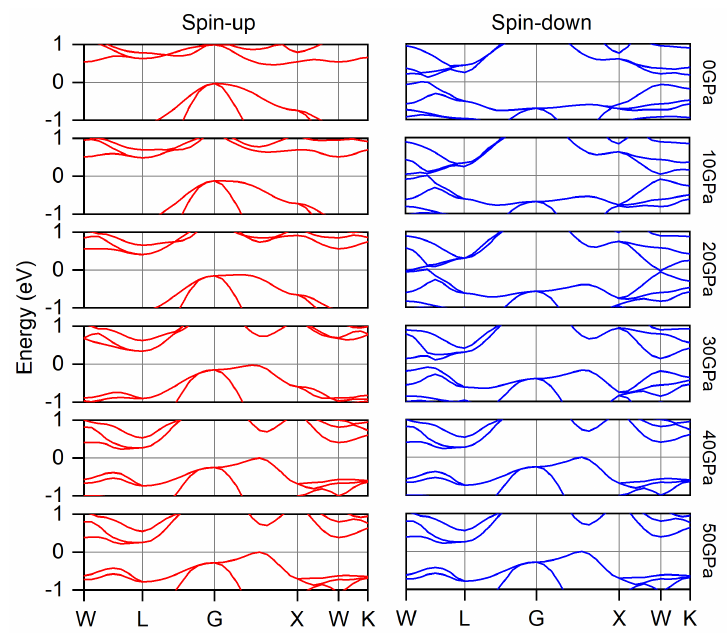
Figure 3. The electronic band structure of Ti 2 MnAl compound around the Fermi energy level (0eV) under different pressure.